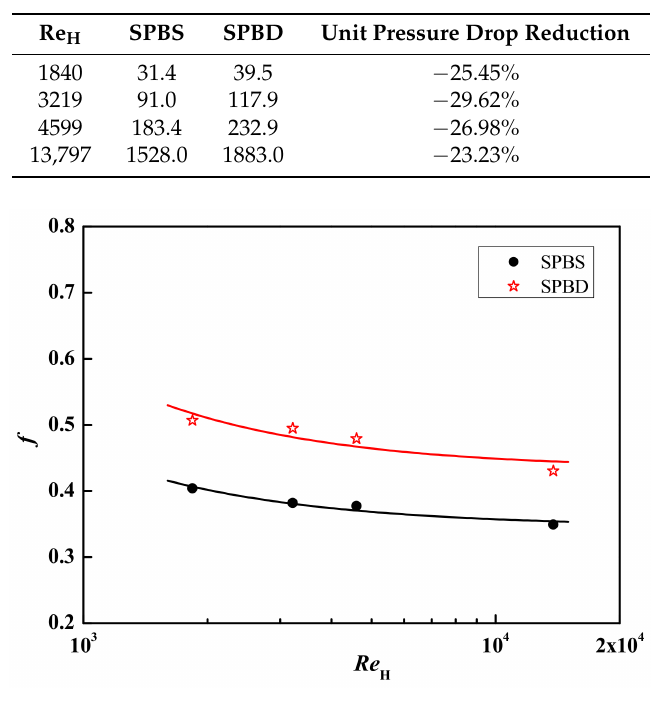
Figure 13. The friction factor of the structured packed bed with smooth or dimpled spheres at N = 1.15.